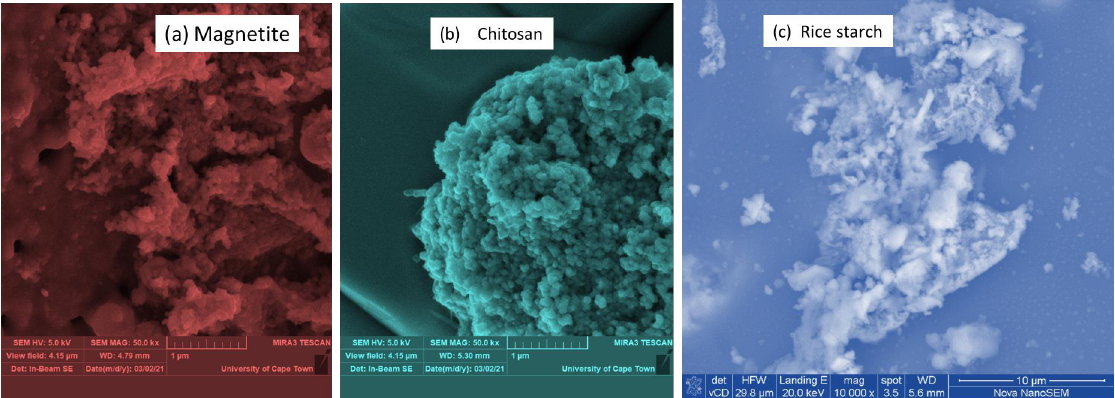
Figure 2. SEM images ( a ) magnetite, ( b ) chitosan, and ( c ) rice starch. Composite surface images (Figure 3a – f) were captured at magnifications of 10x and 50x and a microscale of 5 µm to demonstrate the transformation of un-magnetized coag- ulants into magnetized coagulants. These binary composites, at various ratios, were seen to have a rough surface. The magnetized chitosan in various ratios (Figures3a – c) has a compact surface that exhibits a light aggregate, and more pores are visible, particularly in Figure 3c. Similar findings were drawn from Figure 3d-f, the last of which revealed a po- rous surface with a clearly defined porous structure. The modifications might be the result of calcination at a high temperature (550 °C), which has been observed to alter crystal structures and increase porosity.